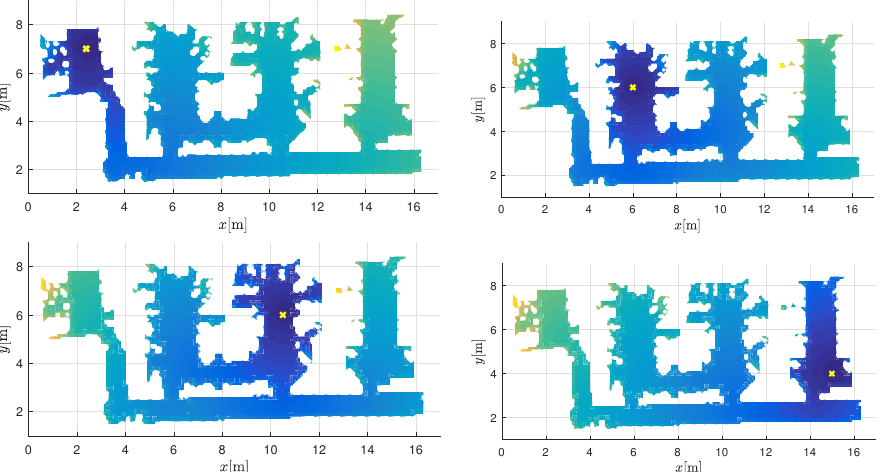
Figure 13. Four interpolated potential fields are used in the navigation functions N i ( y , x , ϕ ) ( i ∈ 1, . . . ,4) to find one of the desired target positions G N 1 = [ 2.4,7 ] T , G N 2 = [ 6,6 ] T , G N 3 = [ 10.5,6 ] T , and G N 4 = [ 15,4 ] T from any initial position. The targets are located at the lowest value of the potential field (darkest region) and are marked by a cross.